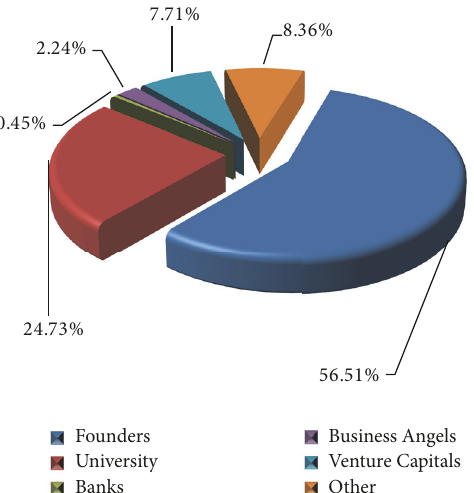
Figure1:AveragedistributionofSPOsequityatformation(percent- age).